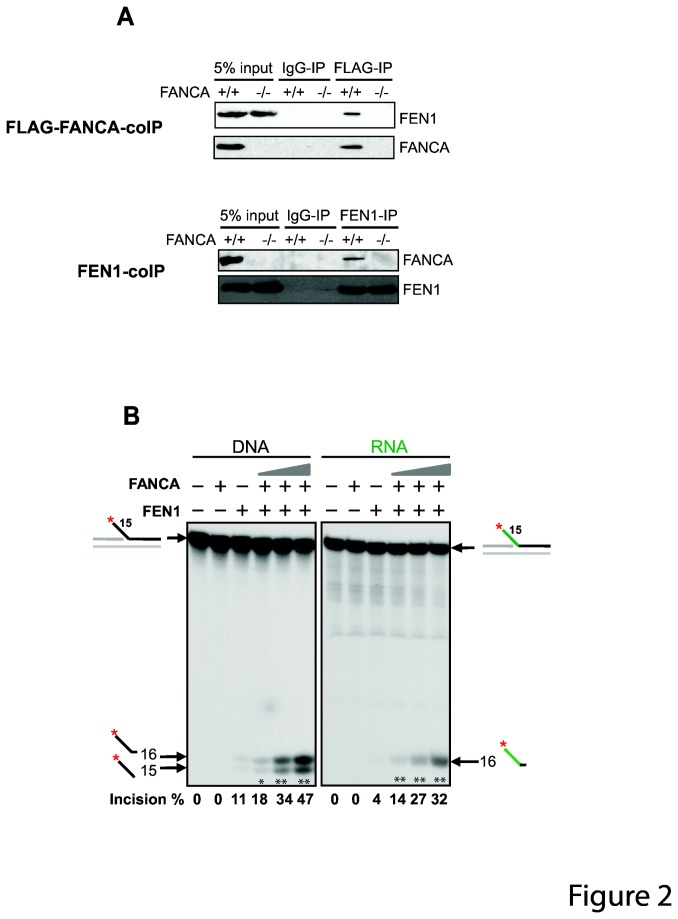
FANCA interacts with FEN1 and stimulates its incision activity.(A) Reciprocal co-immunoprecipitation was performed in FANCA-null (-/-) and FLAG-FANCA-complemented (+/+) cells. FLAG-FANCA was pulled down by a mouse FLAG antibody and FEN1 was pulled down by a rabbit FEN1 antibody (Bethyl). Detection of the FANCA and FEN1 was carried out by antibodies with different origins as described in Materials and Methods. (B) FANCA stimulates FEN1 activity. Both the DNA (black) and RNA (green) flap substrates were used at 2 nM. The concentration of FEN1 was 0.2 nM for DNA flap and 0.1 nM for RNA flap. The concentration of FANCA indicated were 2.5, 5, 10 nM. FANCA+/FEN1- lanes: 10 nM of FANCA. Reaction products were resolved in 10% denaturing polyacrylamide gel. Arrows point to the incision sites. The incision rate is quantified and shown on the bottom. **, p<0.01; *, p<0.05 when compared to the reaction with FEN1 alone.